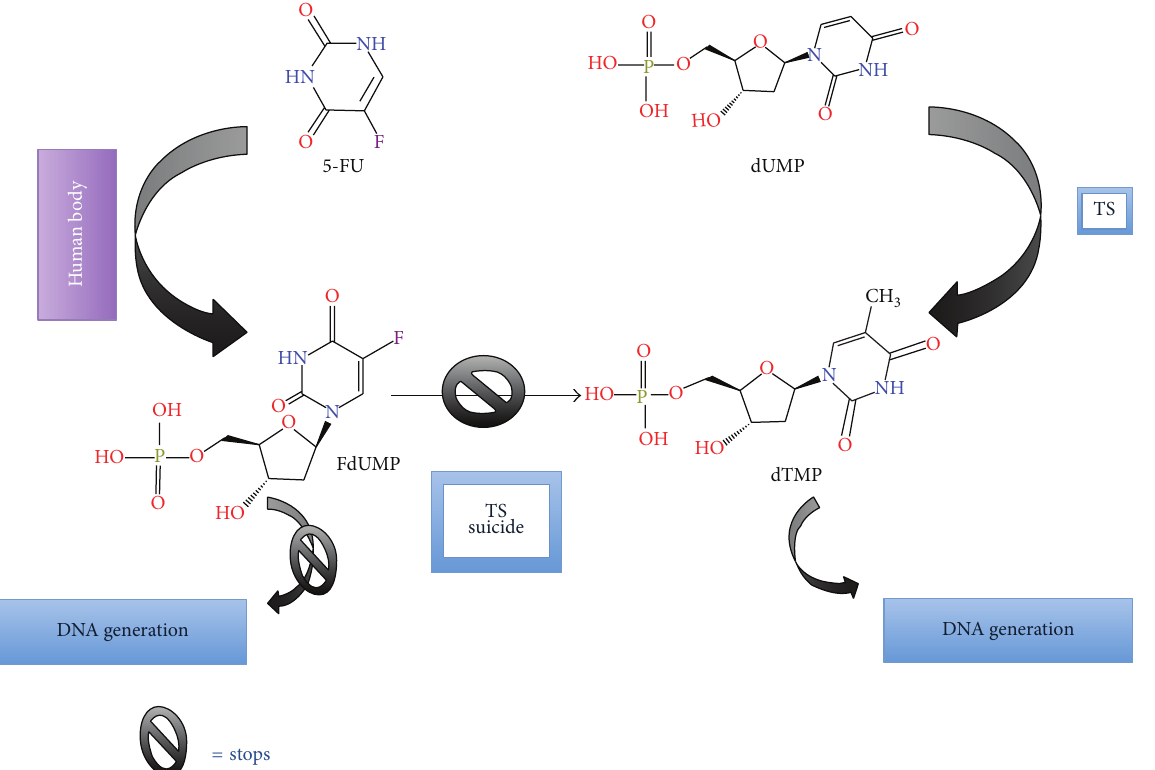
Figure 2: Mechanism of action of the enzyme TS on dUMP to produce the methylated dTMP leading to DNA generation and cell